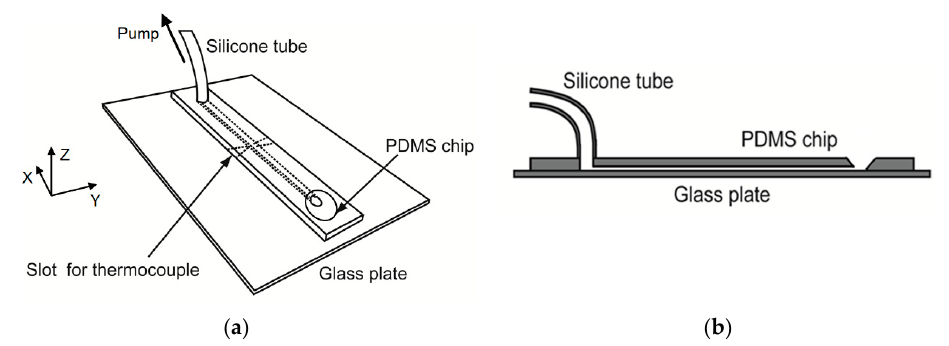
Figure 2. Mini-channel: ( a ) Bird’s-eye view; ( b ) Cross section.